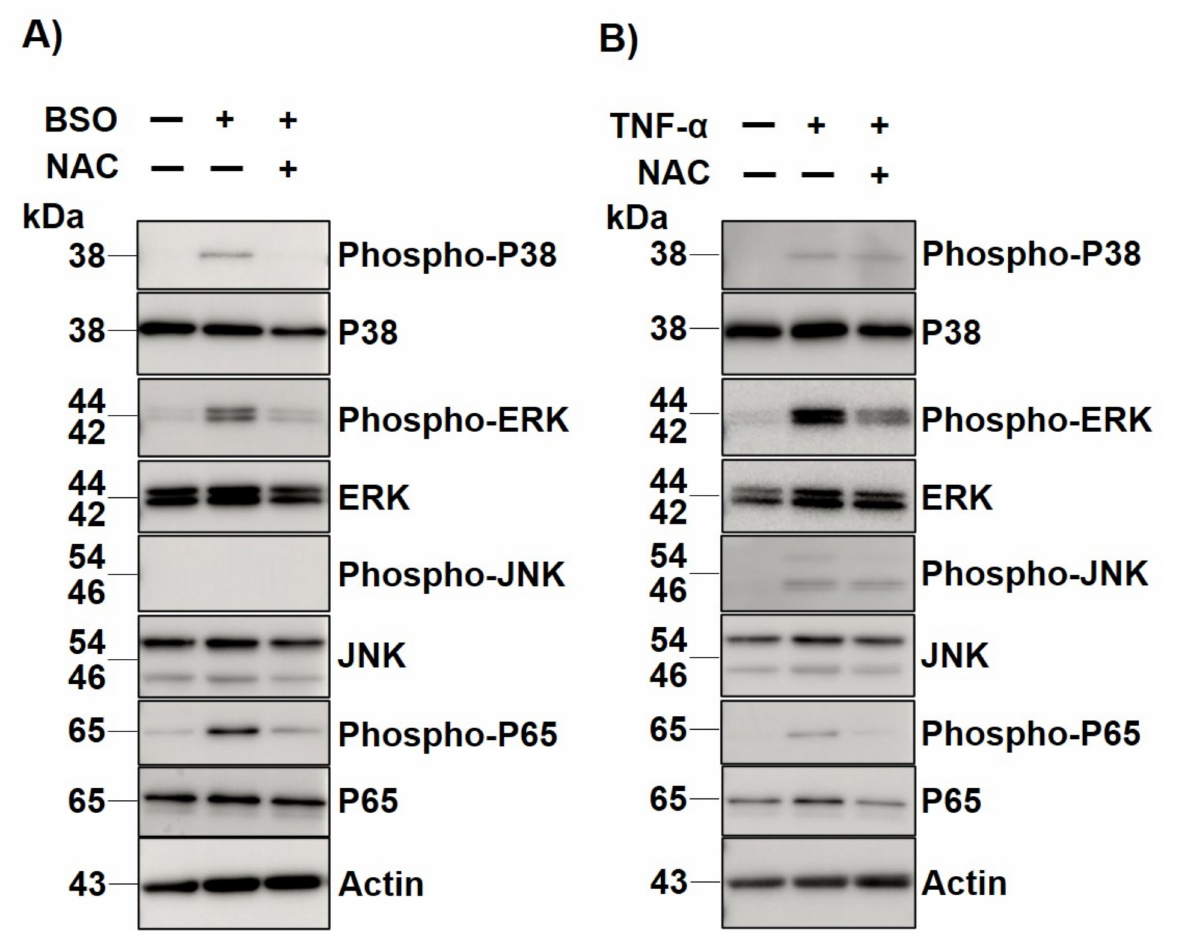
Figure 4. Western blot analysis for BSO- or TNF- α -mediated MAPKs and NF- κ b p65 phosphorylation. ( A ) MAPKs phosphorylation, including p38, Erk 1/2, and p65, was enhanced after buthionine sulfoximine (BSO) treatment, but was suppressed by additional N-acetylcysteine (NAC) treatment. ( B ) TNF- α mediated Erk 1/2 and p65 phosphorylation was neutralized by NAC treatment, but not p38 and